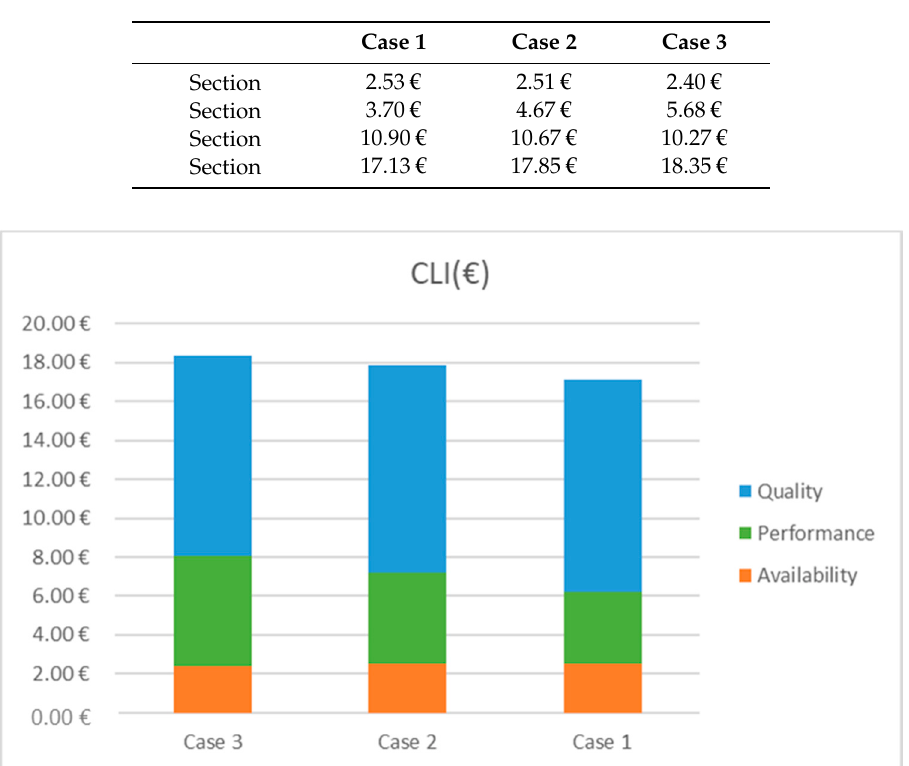
Table 3. Test results.